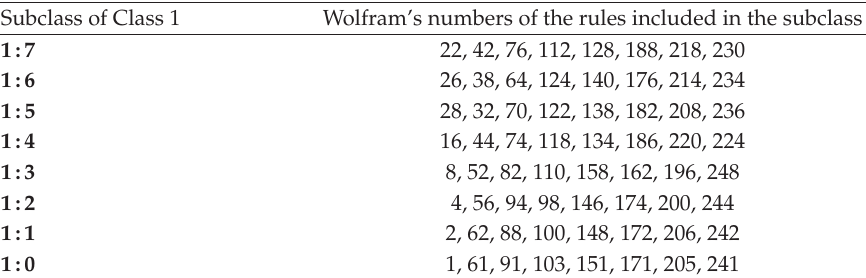
Table 4: Subclassification of Class 1 Rules.